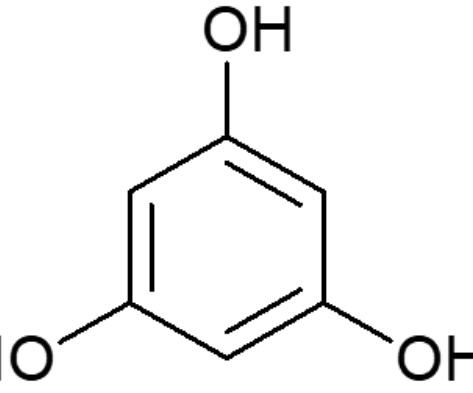
Figure 1. Structure of phloroglucinol.